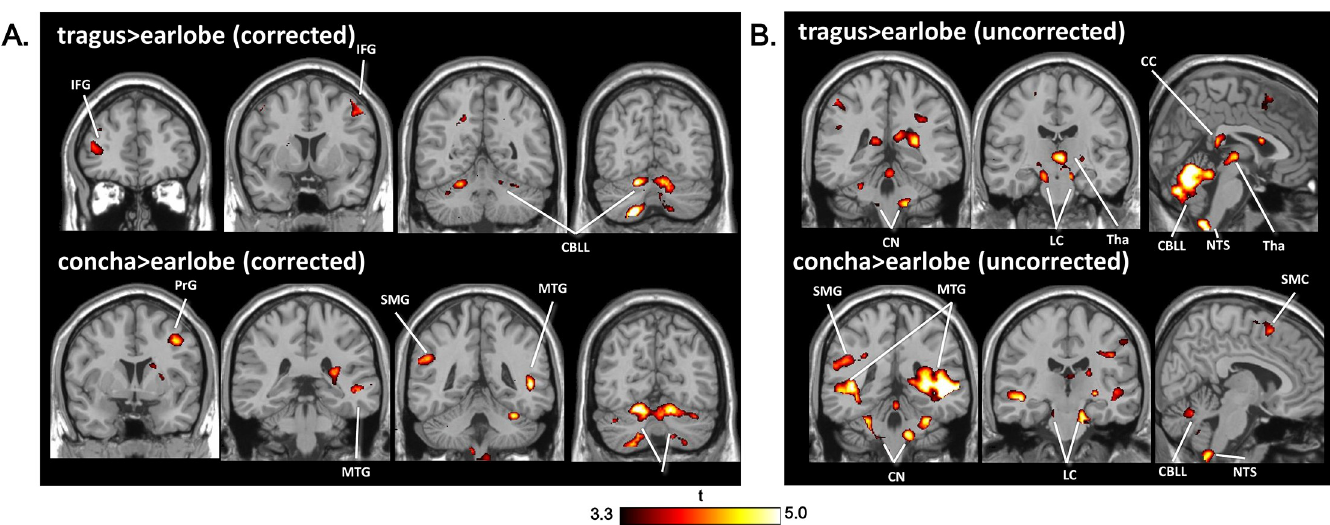
Fig 2. Spatial maps showing differences between the active stimulation locations and the sham stimulation location, corrected (A) and uncorrected (B) for multiple comparisons. CBLL: cerebellum, CC: corpus callosum, CN: cochlear nucleus, IFG: inferior frontal gyrus, LC: locus coeruleus, MTG: middle temporal gyrus, NTS: nucleus of solitary tract, PrG: precentral gyrus, SMC: supplementary motor cortex, SMG: supramarginal gyrus, Tha: thalamus.